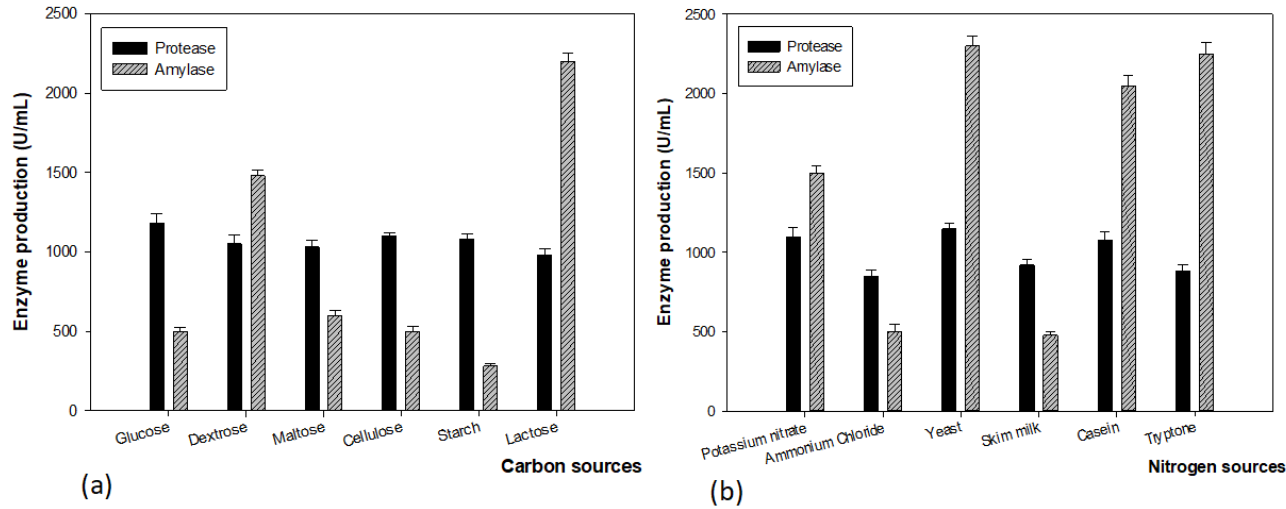
Figure 6. The effect of the carbon ( a ) and nitrogen sources ( b ) (1% w / v ) on protease and amylase production of strain FW2 at 45 °C, initial pH 7–7.5 for 72 h. The experiments were carried out in triplicate. Error bars demonstrated standard deviation.